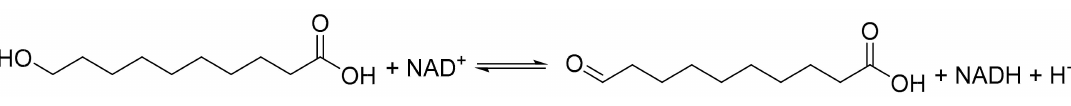
Figure 5. Metabolic pathway of 10-hydroxydecanoic acid